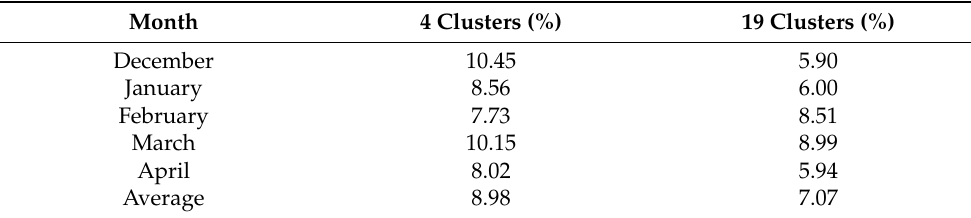
Table 2. Number of PV plants obtained using different clustering